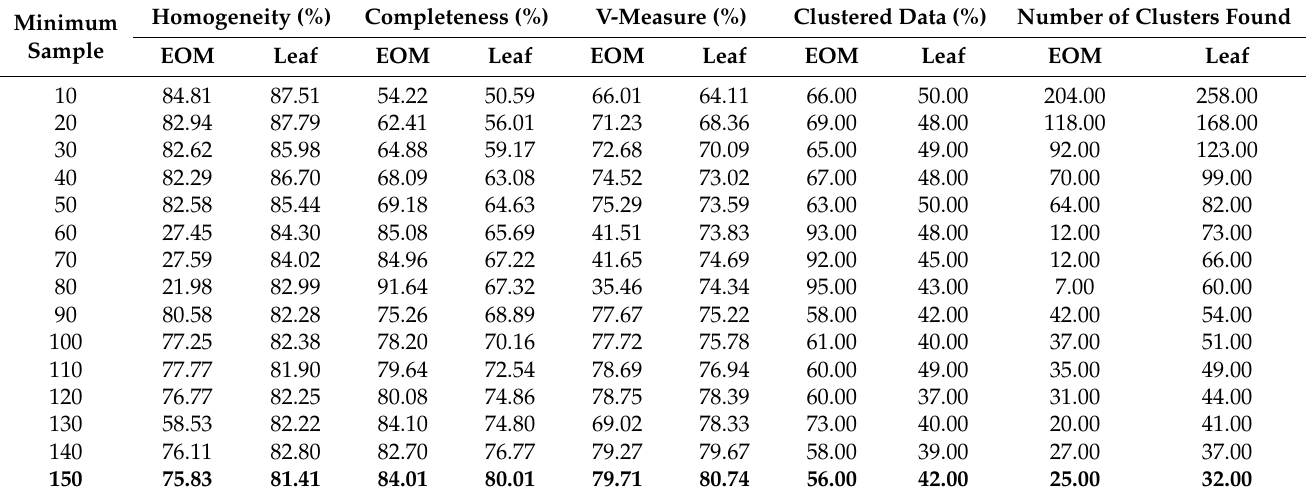
Table 5. Mean HDBSCAN clustering results for the two examined cluster extraction approaches.